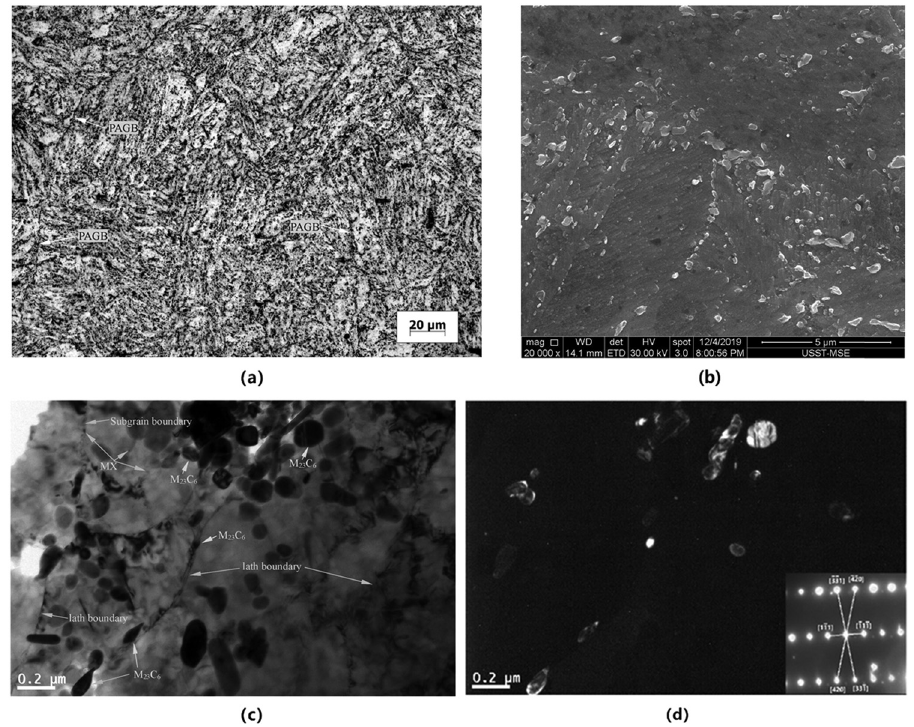
Figure 2: ( a ) OM image, ( b ) SEM image, ( c ) TEM bright - fi eld image, and ( d ) TEM dark - fi eld image and SAED of M 23 C 6